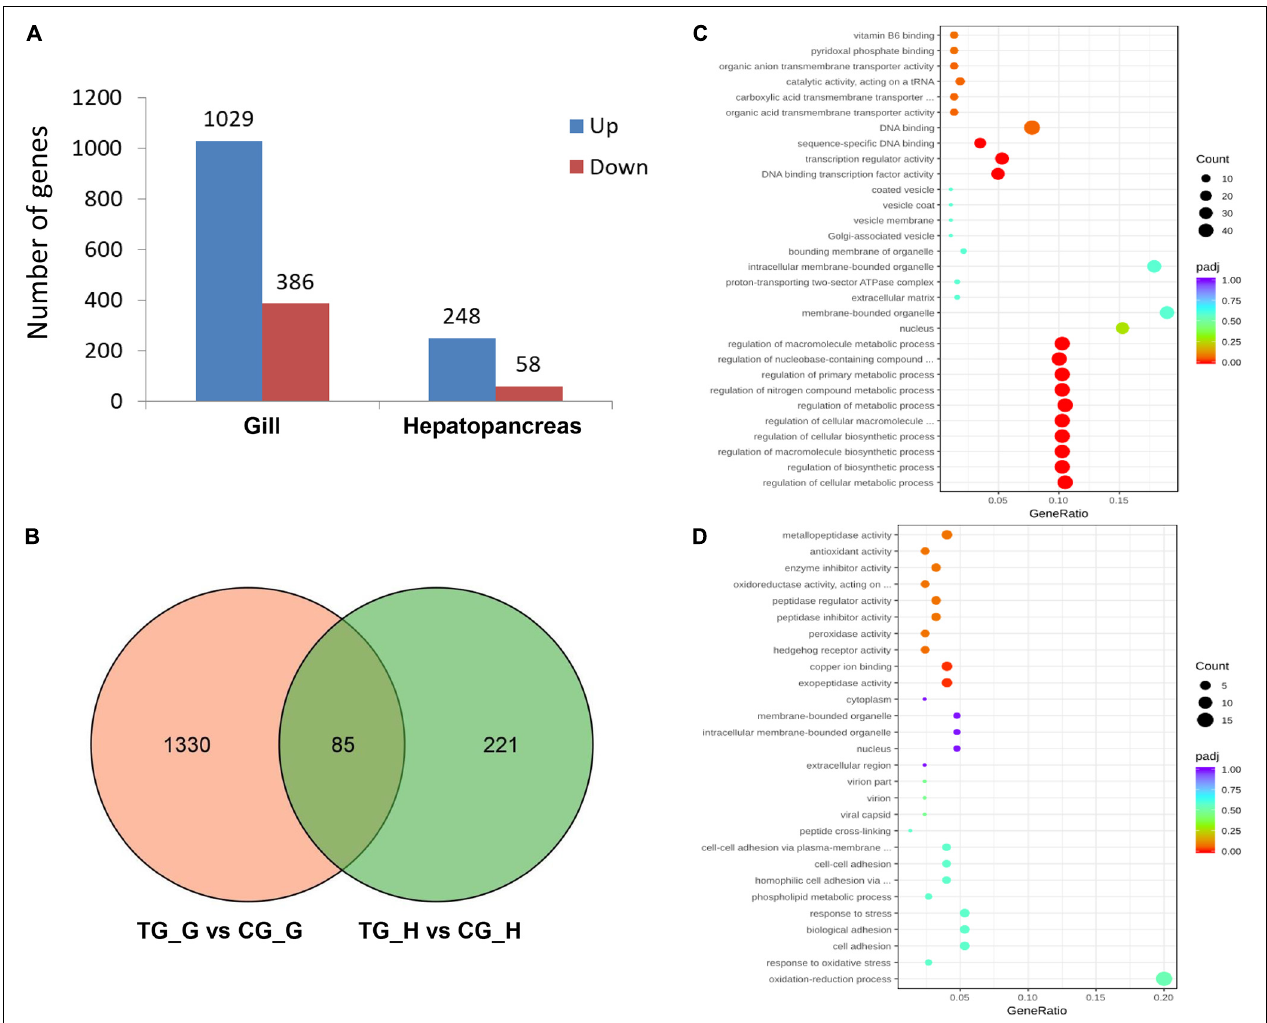
FIGURE 2 | A summary of differentially expressed genes (DEGs) of the gill and hepatopancreas in S . constricta exposure to acute ammonia. (A) The numbers of DEGs in the gill and hepatopancreas. (B) Venn diagram of DEGs shared between gill and hepatopancreas. G represents gill and H represents hepatopancreas. (C) Enriched gene ontology (GOs) in the gill. (D) Enriched GOs in the hepatopancreas.